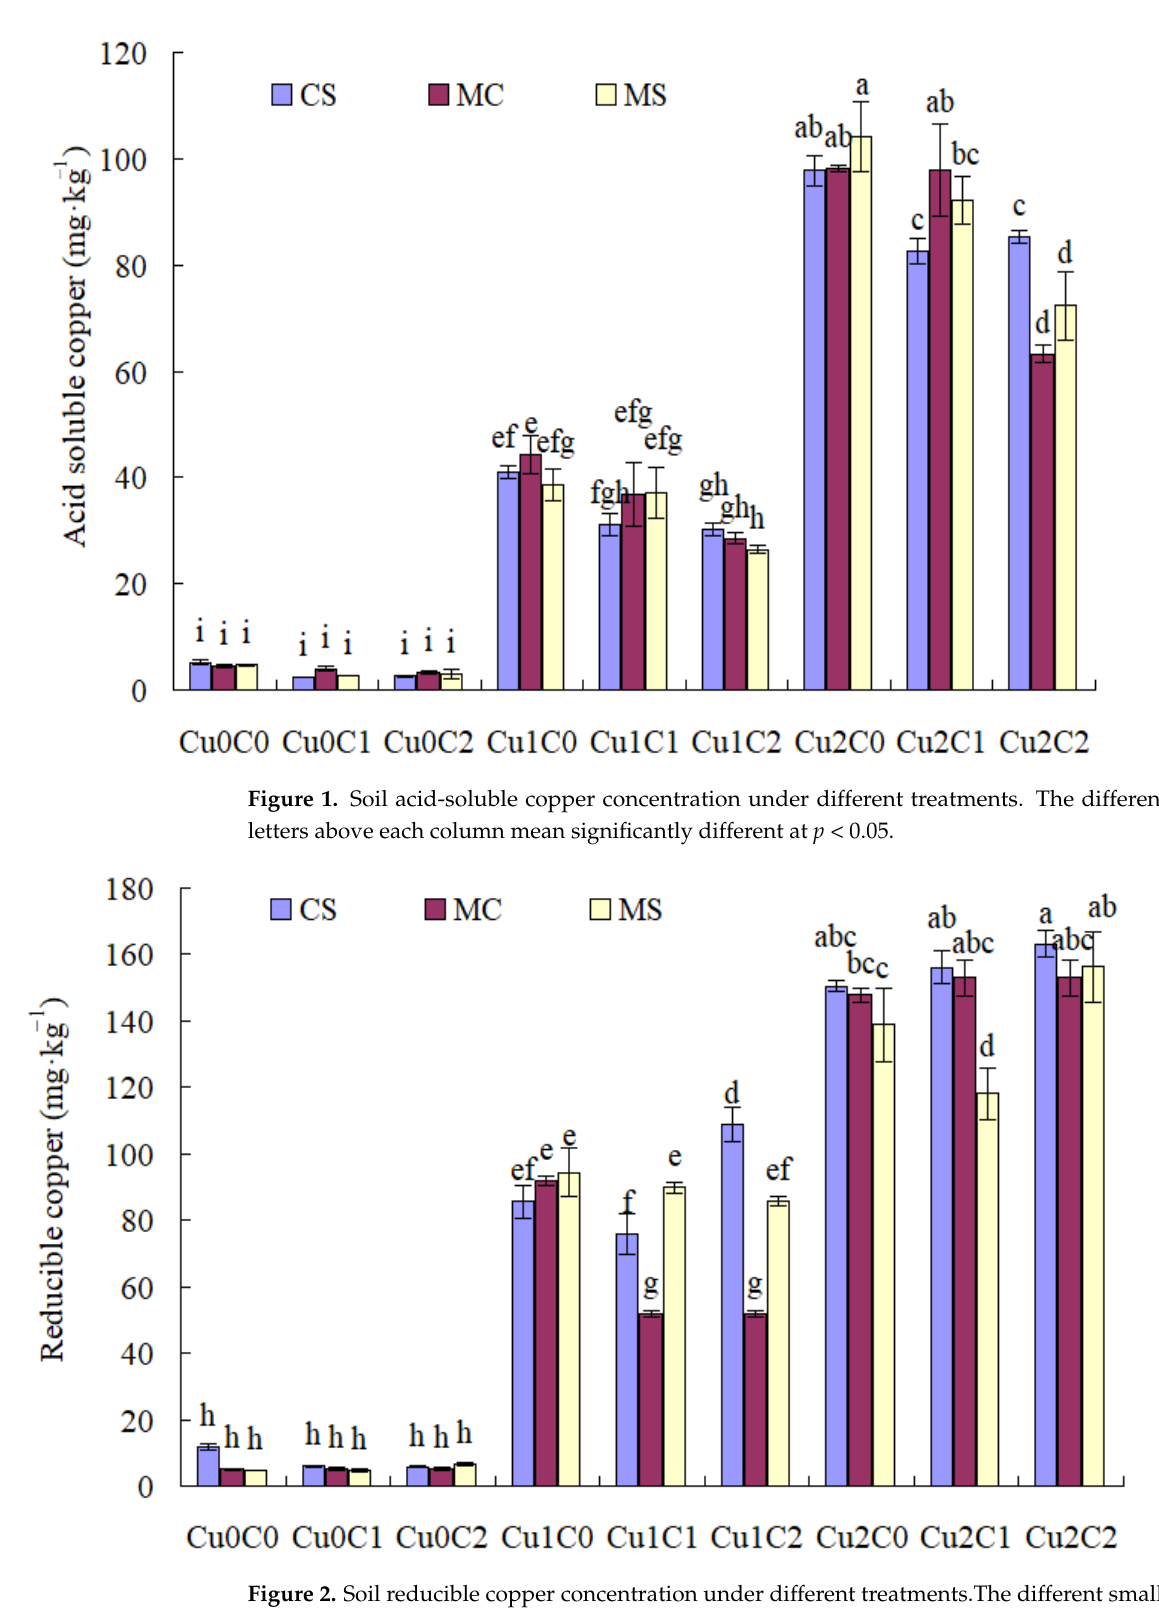
Figure 2. Soil reducible copper concentration under different treatments.The different small letters above each column mean significantly different at p <0.05.